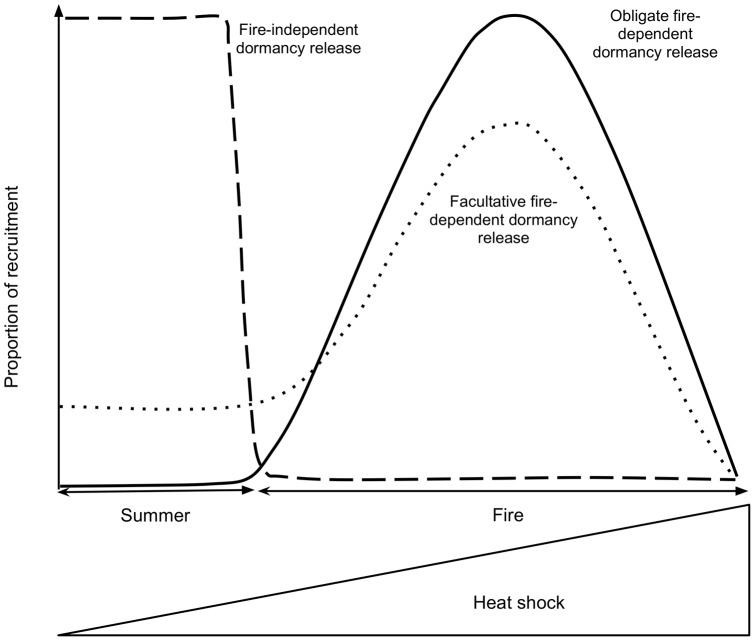
Conceptual model describing recruitment dynamics in mediterranean ecosystems for species with physical dormancy.The x-axis represents an increase in the heat doses reaching the soil (during summer or fires). The y-axis represents the proportion of recruitment associated with dormancy release, for species with different levels of fire-dependent recruitment. For some species, fire is not the main factor shaping seed dormancy and thus they have fire-independent dormancy release and recruitment (dashed line). However, species living in fire prone mediterranean ecosystems have mostly fire-dependent dormancy release, with recruitment strictly related to fire (obligate fire-dependent dormancy release, continuous line) or with a small proportion of recruitment independent of fire (facultative fire-dependent dormancy release, dotted line).